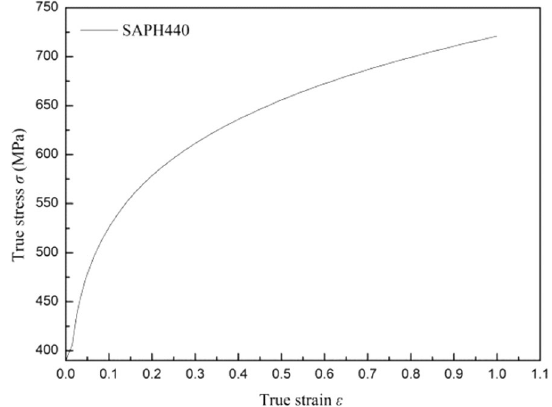
Figure 25 SAPH440 true stress-strain curve